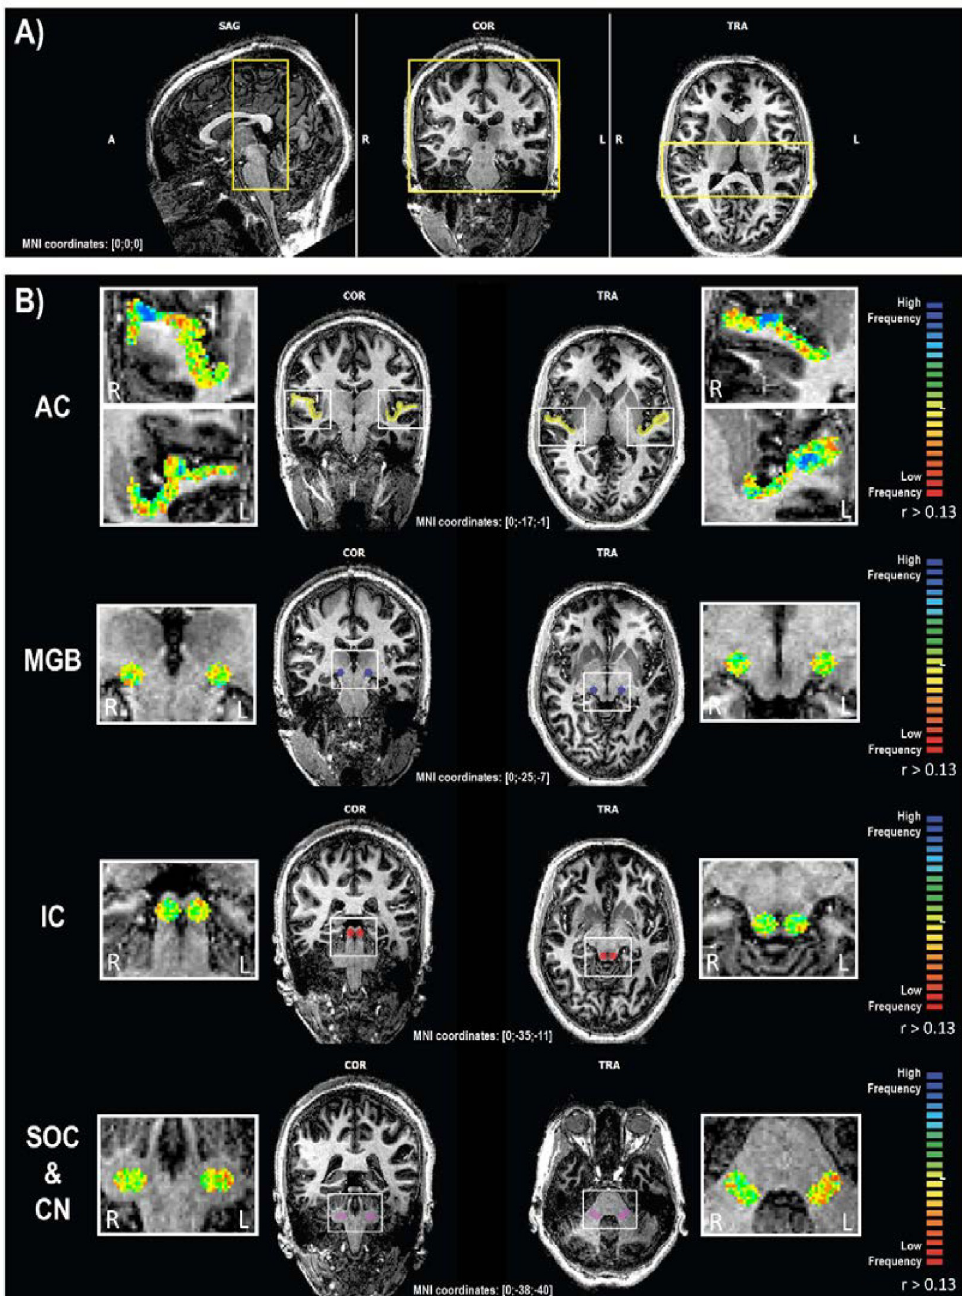
Fig 2. fMRI acquisition along the auditory pathway. A) fMRI slab acquisition (yellow box) projected onto the MP2RAGE; B) fMRI activations reflecting gradients of frequency preferences within the ROIs of the auditory pathway. Tonotopic maps were projected onto the MP2RAGE and masked by the ROIs. The second and third columns illustrate the localization of the ROIs in the coronal and transversal view. The threshold of the correlation values was set to r > 0.13 for visualization purposes only. Voxels preferring low frequencies are represented in red, while those preferring high frequencies are in blue. SAG: Sagittal; COR: Coronal; TRA: Transverse; A: Anterior; P: Posterior; R: Right; L: Left; AC: Auditory cortex; MGB: Medial geniculate bodies; IC: Inferior colliculi; SOC & CN: Superior olivary complex and cochlear